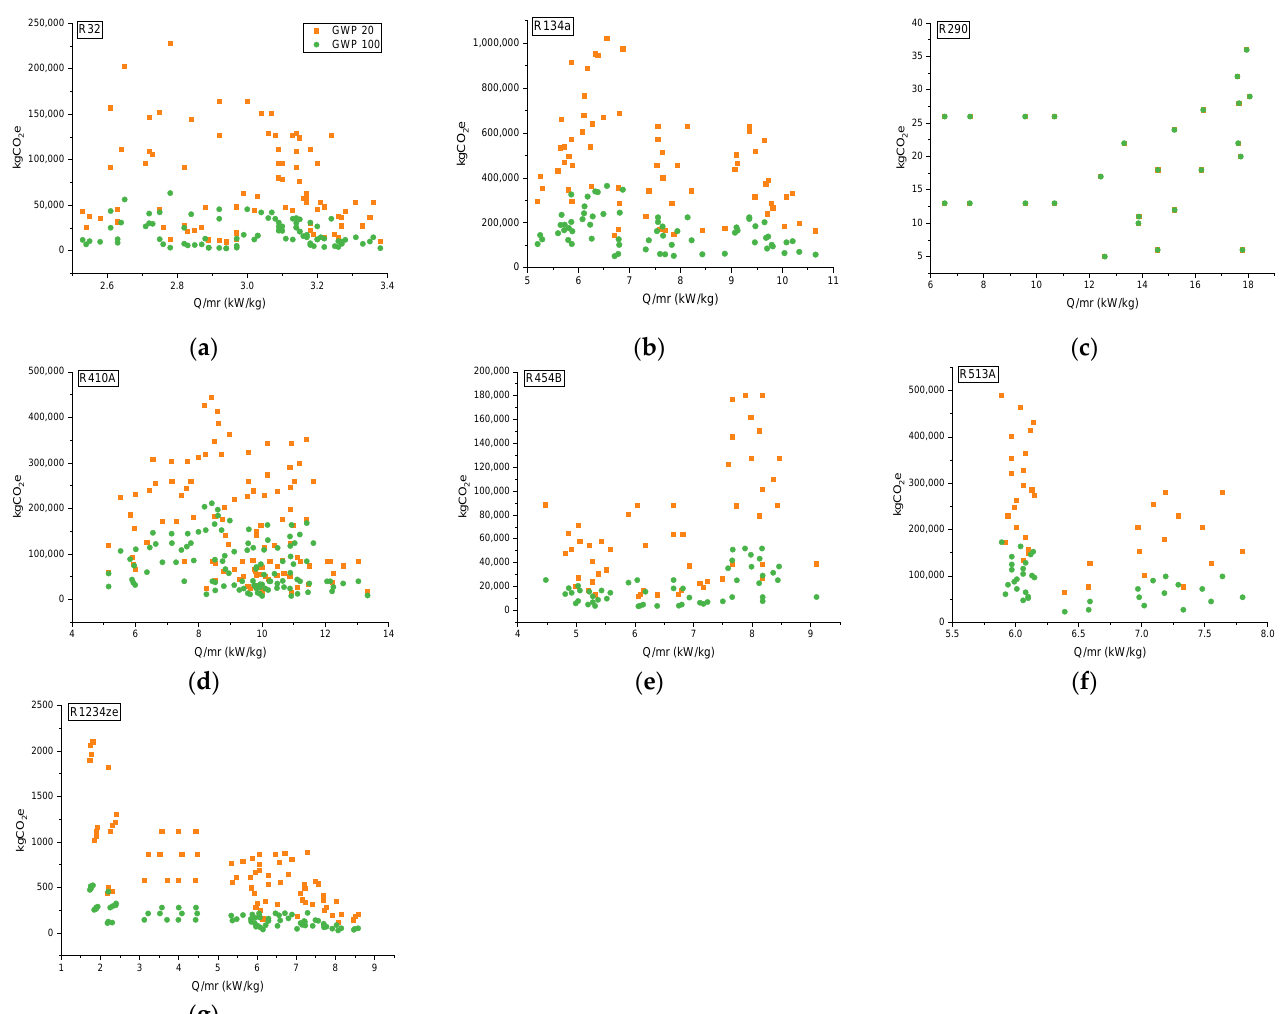
Figure 9. Equivalent CO 2 emissions in released to unit power of the refrigerant charge (kW/kg) for: ( a ) R32, ( b ) R134a, ( c ) R290, ( d ) R410A, ( e ) R454B, ( f ) R513A, ( g ) R1234ze. Green dots—kg CO 2 e TH = 100, Orange dots—kg CO 2 e TH = 20.